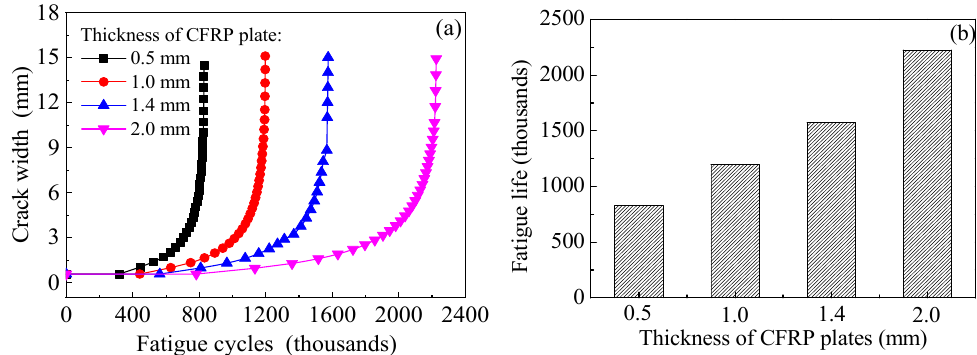
Figure 24. Effect of stiffness of CFRP plate on ( a ) the crack propagation curves and ( b ) the fatigue life of the corroded steel plate strengthened with CFRP